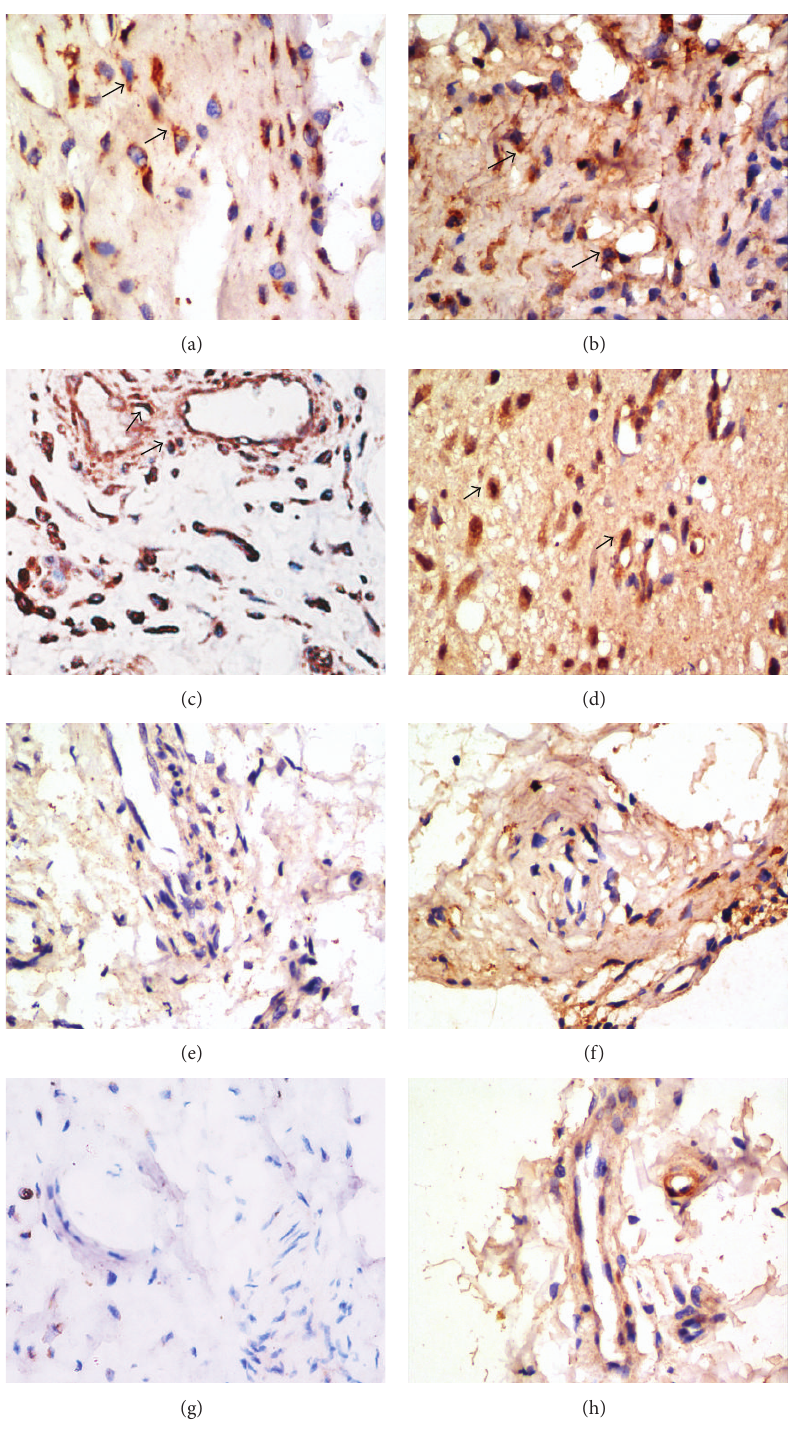
Figure 2: Shh, Ptch1, Smo, and Gli1 were highly expressed in RA synovial tissue (original magnification × 400). Immunohistochemistry demonstrated that Shh, Ptch1, Smo, and Gli1 were expressed in synovium from RA patients ((a), (b), (c), (d)). Localized expression of Shh was observed at the cell membrane and in the cytoplasm of synoviocytes, mainly at the cell membrane (a); expression of Ptch1 and Smo was observed in the plasma of synoviocytes ((b), (c)). Gli1 was expressed mainly in the nucleus of synoviocytes (d). Shh, Ptch1, Smo, and Gli1 were expressed in synovium from patients with knee trauma in a similar pattern, but their expression levels were relatively low compared to those in RA synovium. (a), (b), (c), and (d) were RA specimens; (e), (f), (g), and (h) were controls. (a) and (e): Shh; (b) and (f): Ptch1; (c) and (g): Smo; (d) and (h): Gli1. Shh, Sonic hedgehog; Ptch1, patched 1; Smo, smoothened; Gli1, glioma-associated oncogene